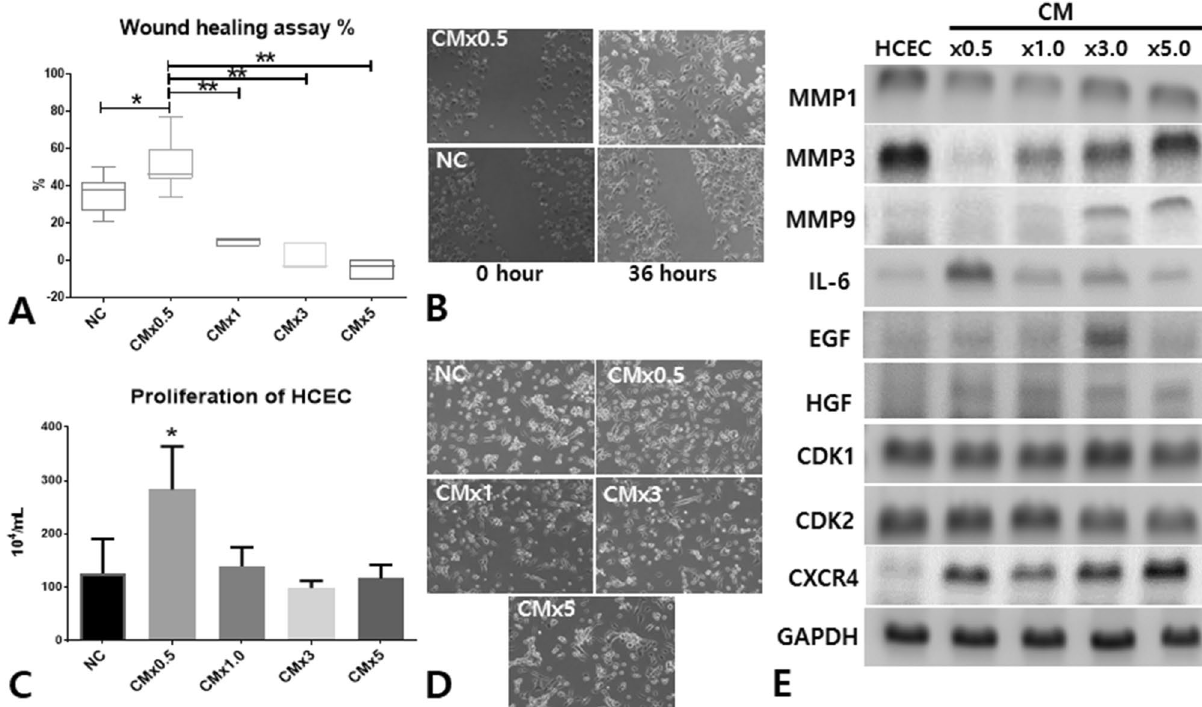
Figure 7. Wound healing and proliferation assay for HCECs depending on CM concentrations (× 0.5, × 1.0, × 3.0, × 5.0). Culture media for the HCEC migration assay was composed of HCEC